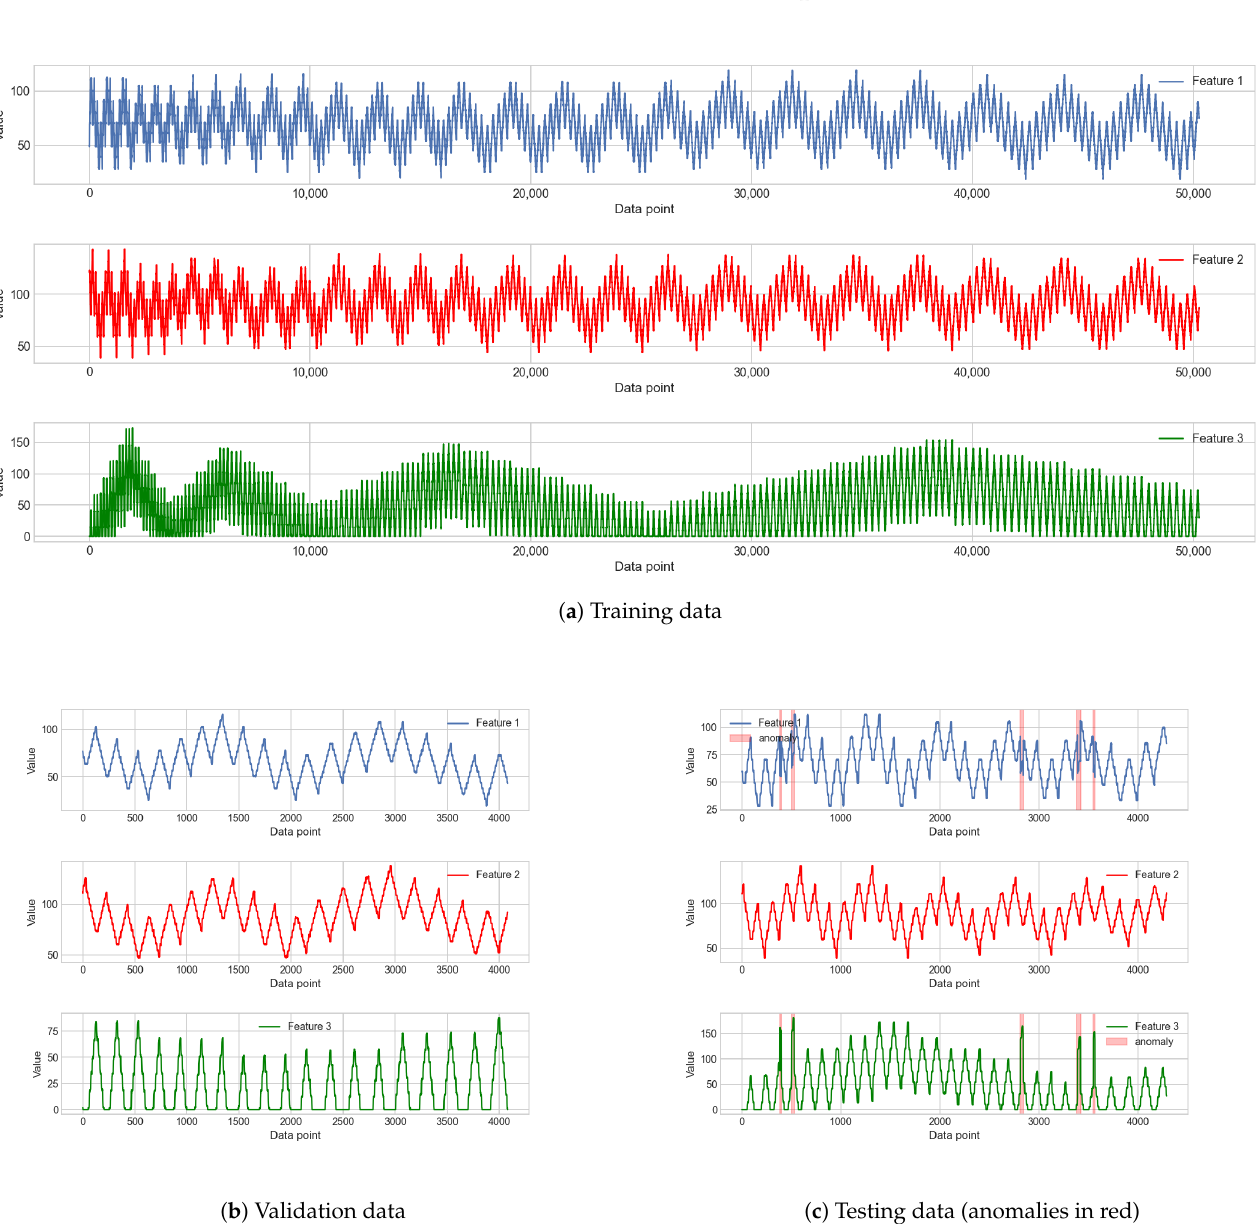
Figure 4. Visualisation of the drone